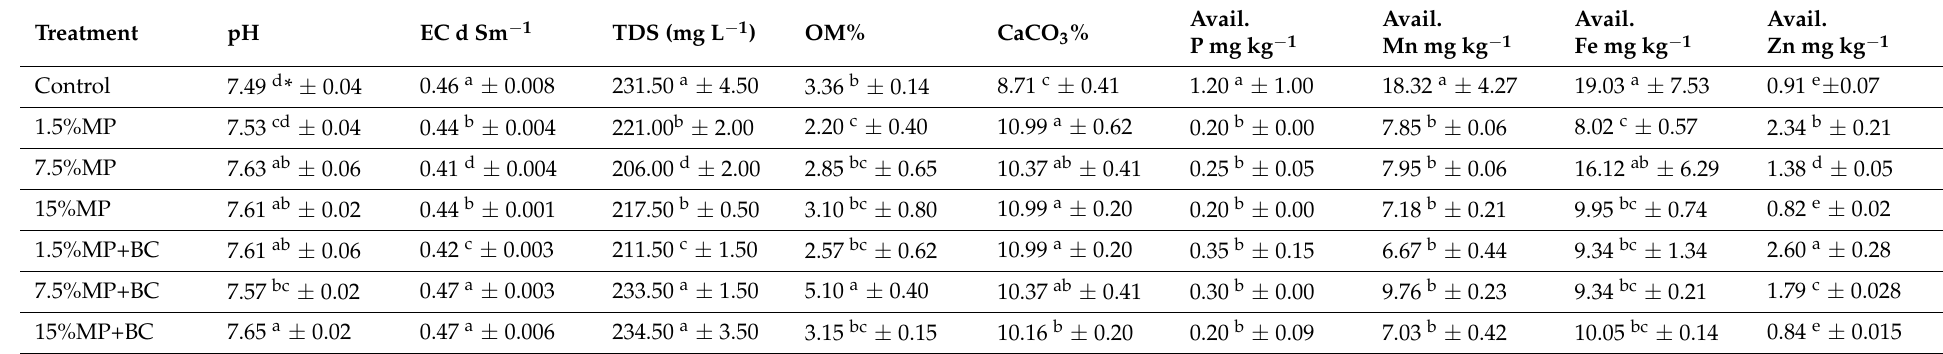
Table 1. Biochar effects on soil properties treated with different levels of